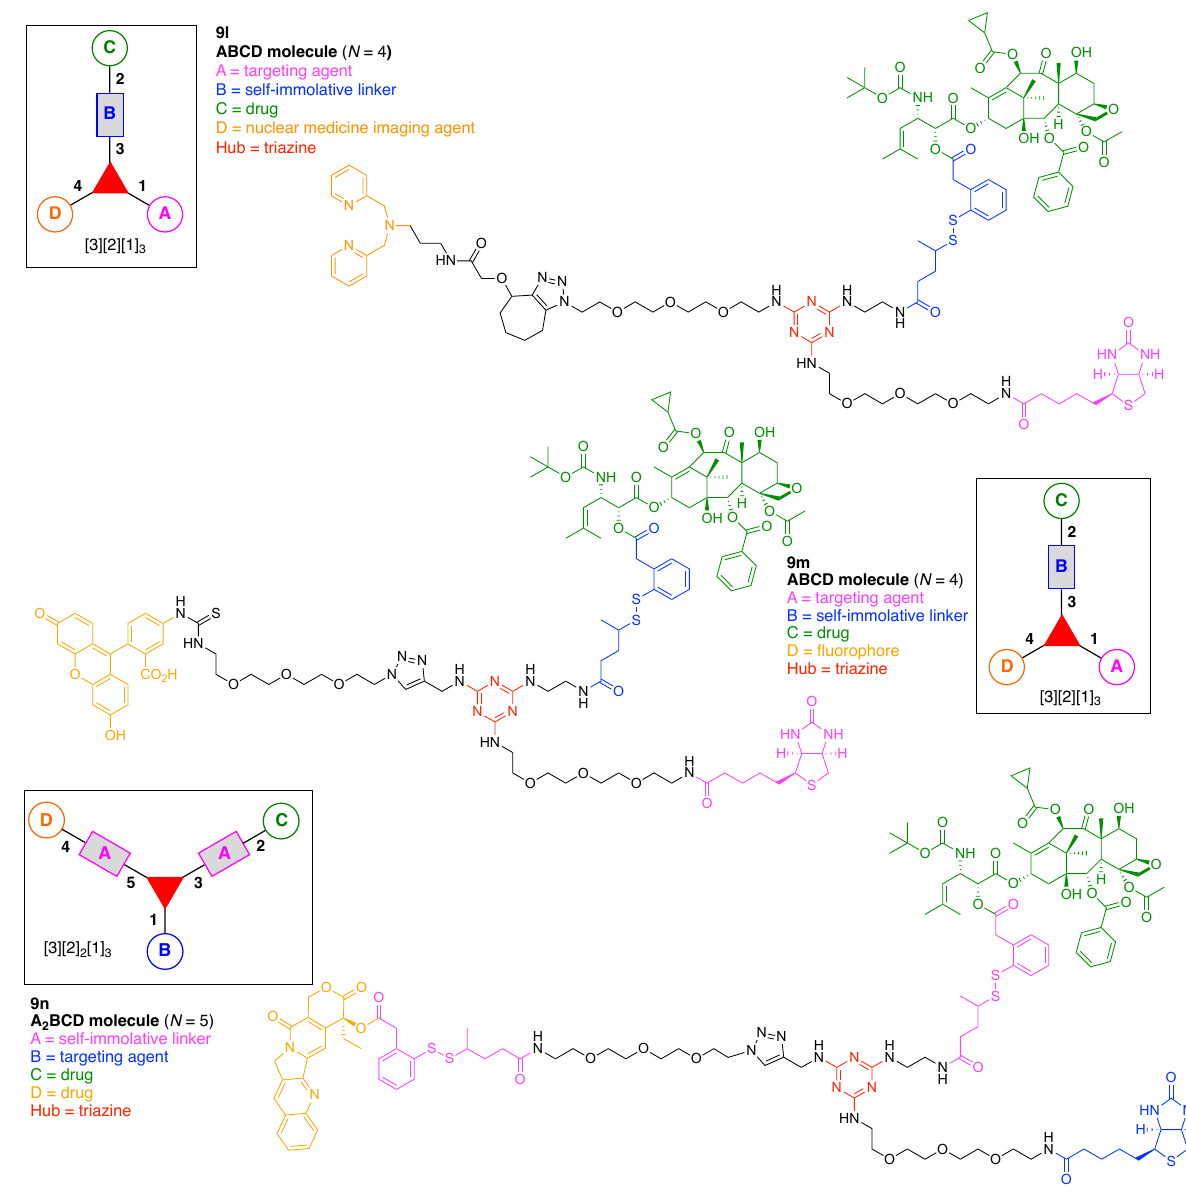
Figure 38. Three examples each containing a single triazine